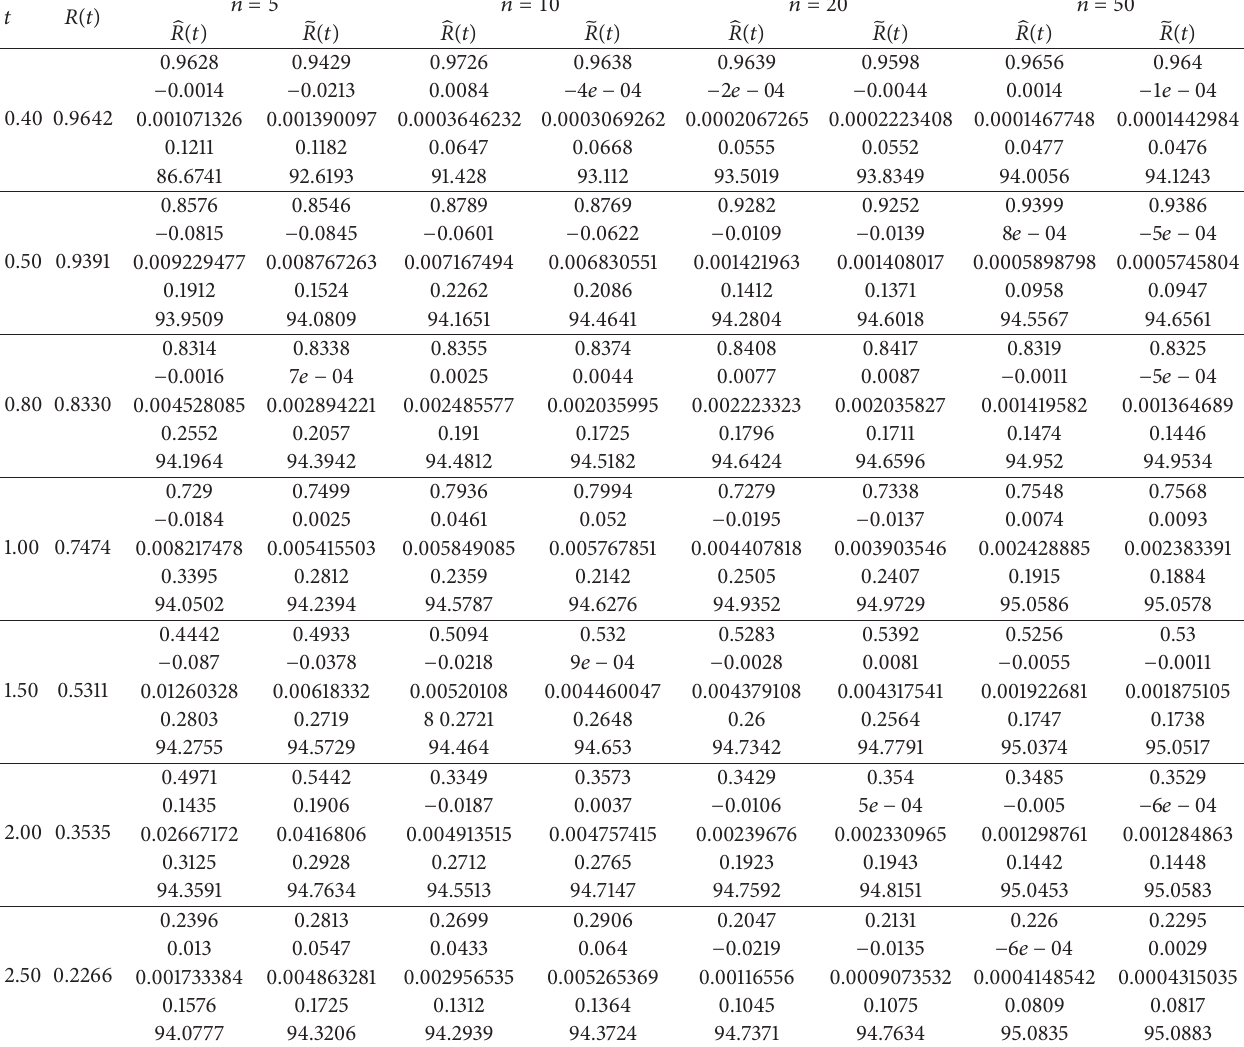
Table 1: Simulation results for 𝑅(𝑡)